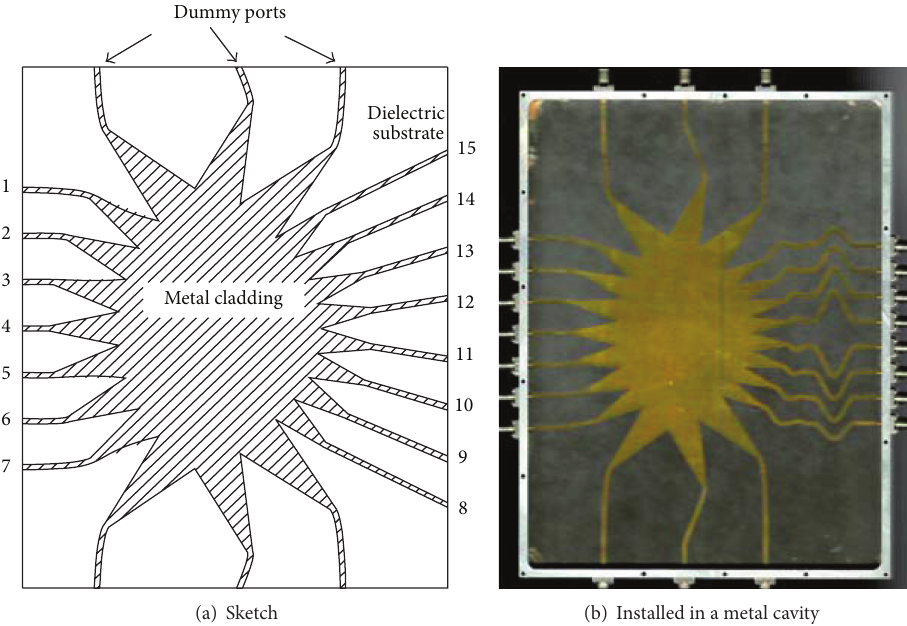
Figure 2: Printed Rotman